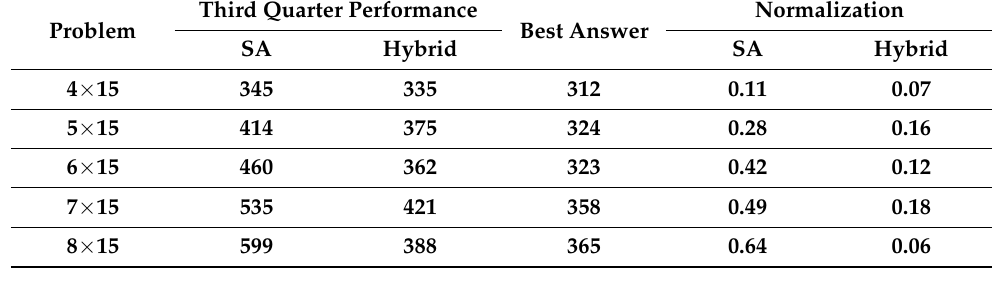
Figure 17. Fitness diagram of SA and hybrid SA in the third quarter (10 ORs). Table 8. Results of executing the SA and hybrid SA algorithms in the third quarter (15 ORs) .